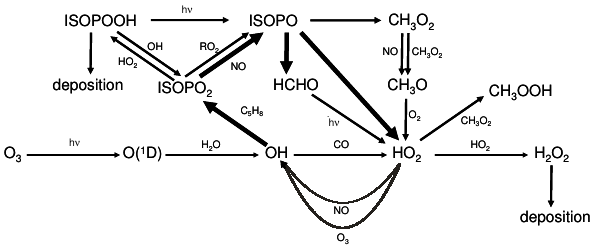
Fig. 8. Simplified schematic showing processes controlling radical budgets during AMMA. Bold lines indicate the dominant reactions in isoprene oxidation chemistry during AMMA.